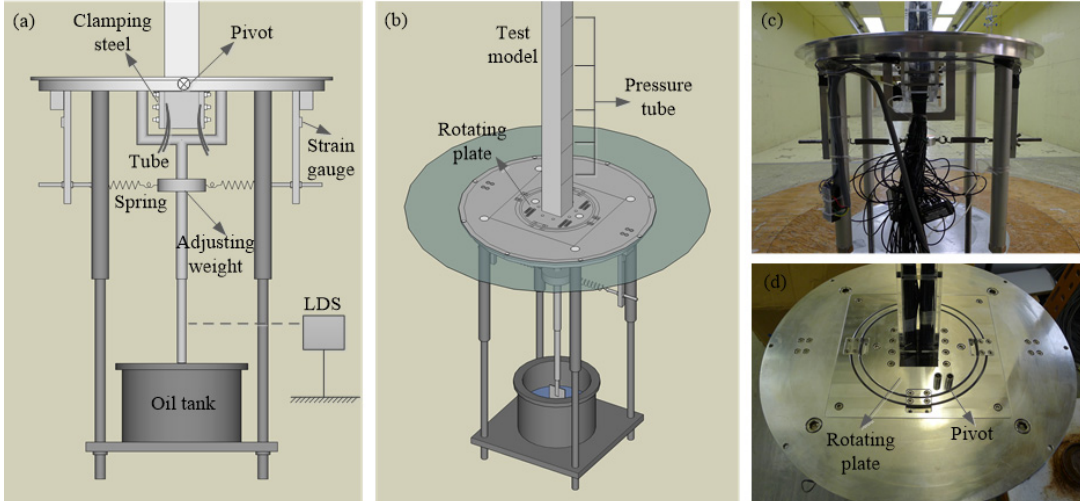
Figure 4. Hybrid aeroelastic-force balance (HAFB) system: ( a ) Plan view of the test rig; ( b ) stereogram of the test rig; ( c ) test rig in a wind tunnel; ( d ) details of rotating plate and pivot [25].